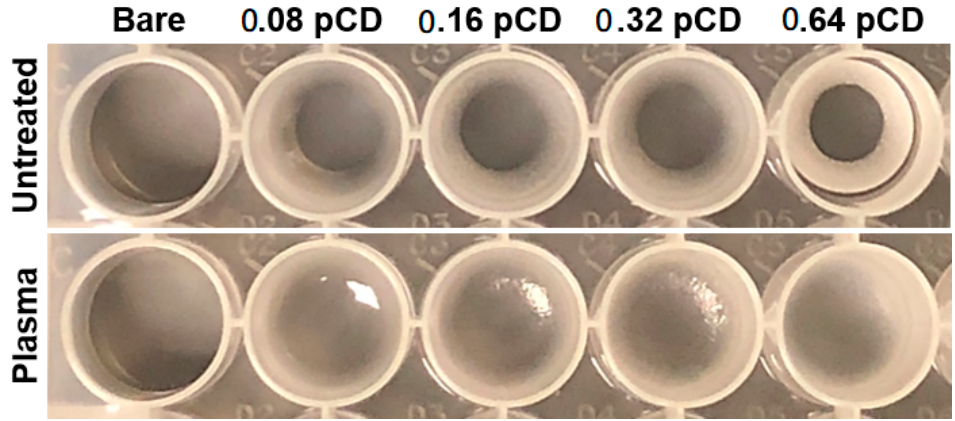
Figure 4. Plasma treatment of PP substrates for 10 min improves macroscopic pCD coating uniformity on wells of a PP 24-well plate. This remained true regardless of the amount of HDI crosslinker added.